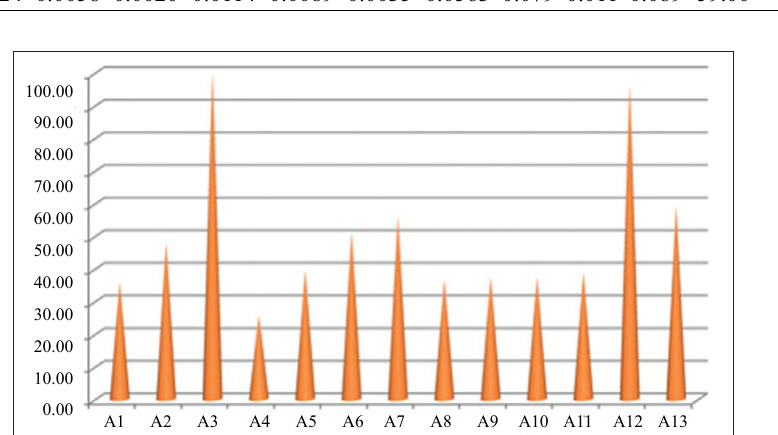
Fig. 4. The utility degrees of alternatives obtained by AHP-COPRAS (Case